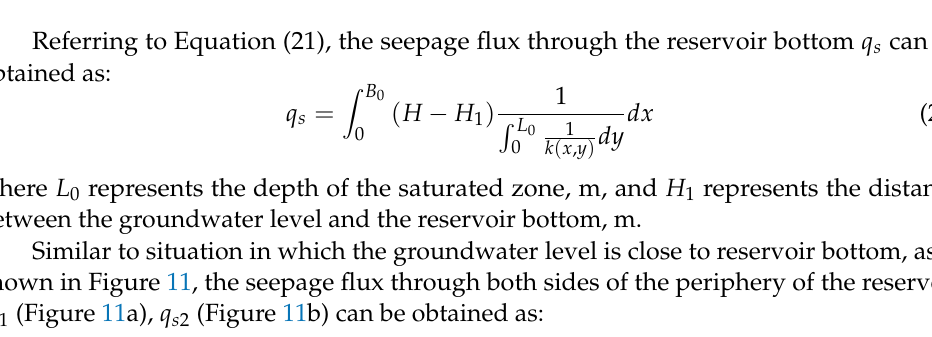
(Figure 11b) can be obtained as: